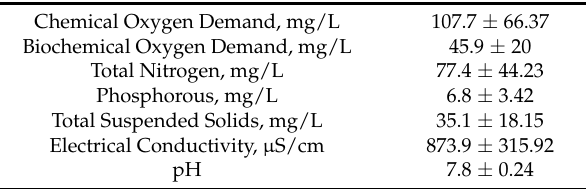
Table 6. Characteristics of the wastewater fed to glass columns for biofilm growth on the tezontle (Average ± SD, n =